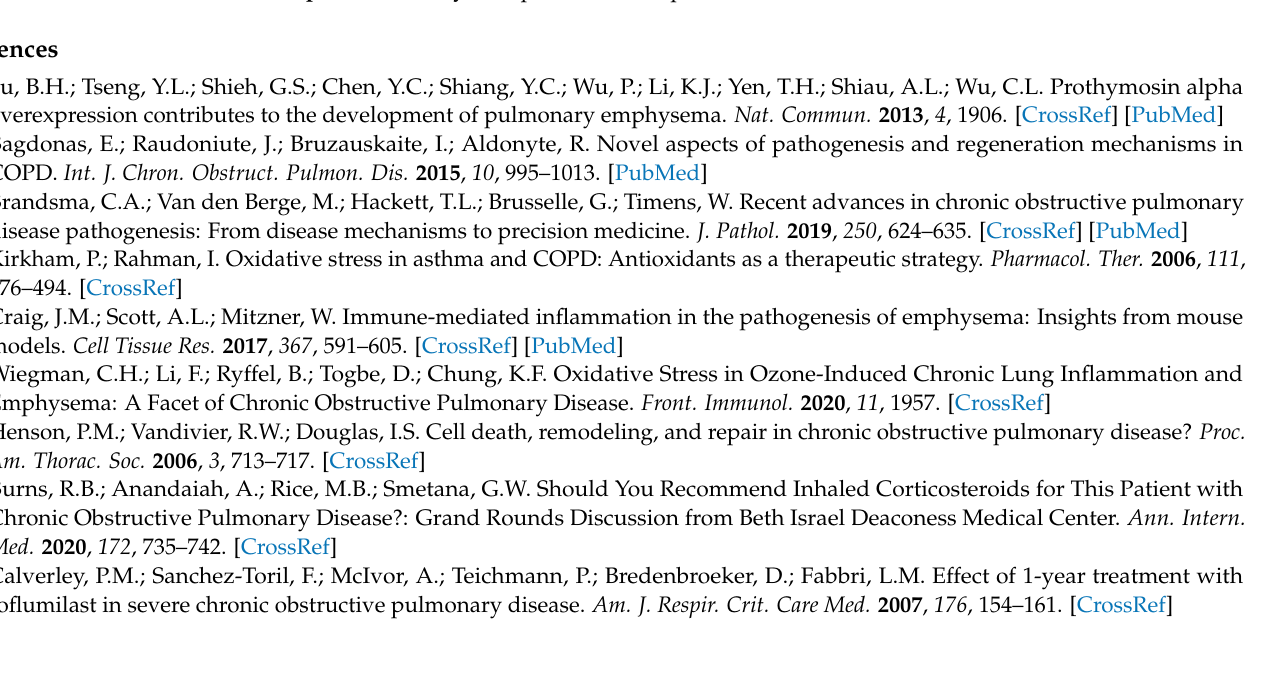
Figure S2: Representative TEM images of Lipo/OMT (scale bar 100 nm), Lipo/OMT@CMCS and CMCS-Lipo/OMT (scale bar 200 nm). Figure S3: The changes in particle size (a), PDI (b) and zeta potential (c) of OMT liposomal preparations stored at 4 ◦ C for 7 days. Each bar represents the means ± SD ( n =